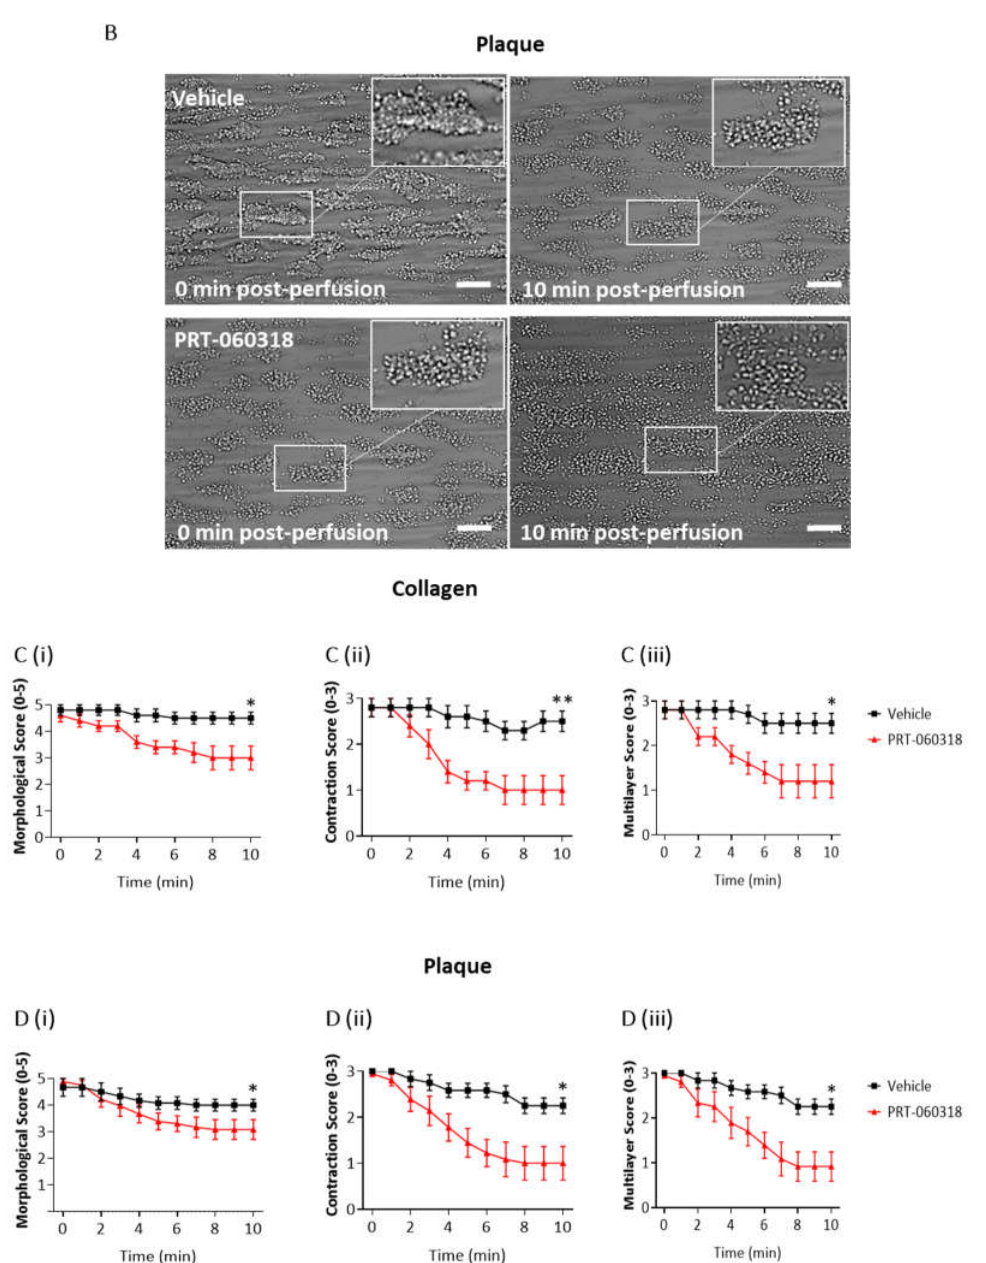
Figure 2. Inhibition of Syk causes loss of contraction and platelet adhesion on collagen and plaque material. Recalcified blood from 6 donors was perfused for 7 min on Horm collagen and plaque at room temperature at a shear rate of 1000 s −1 . ( A, B ) Representative images of aggregates formed on collagen ( A ) and plaque ( B ), taken during post-perfusion at times 0 and 10 min with vehicle or with PRT-060318 ( n = 6). Scale bar = 100 µm. (C, D ) Disaggregation on collagen ( C ) or on plaque ( D ) was monitored by taking brightfield images every 60 sec and measured using morpho- logical ( Ci - Di ), contraction ( Cii - Dii ) and multilayer scores ( Ciii-Diii ) [16]. Aggregates were post- perfused with rinse buffer ± vehicle (DMSO) or the Syk inhibitor PRT-060318 (10 µM). Data are shown as mean ± s.e.m. * p < 0.05, ** p <